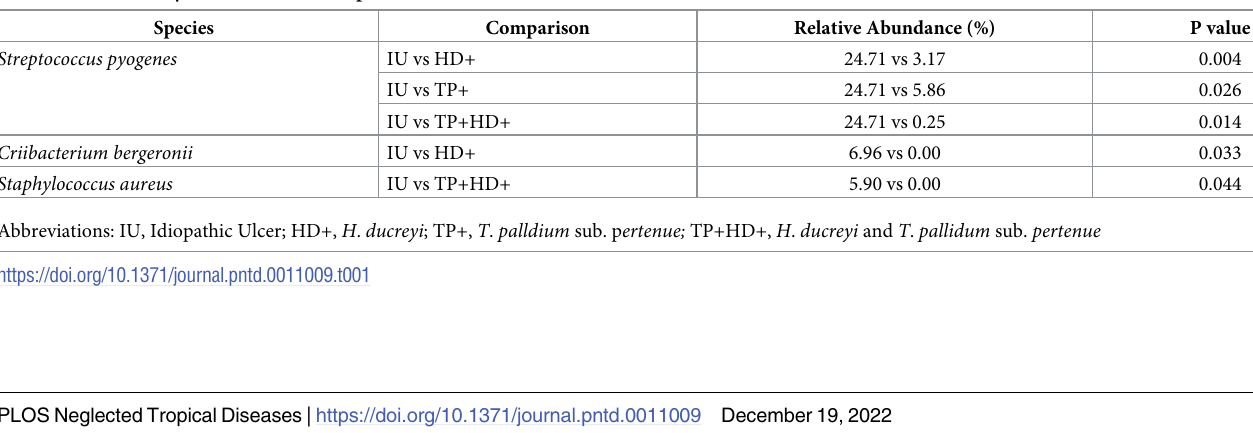
Table 1. Differentially Enriched Bacterial Species in